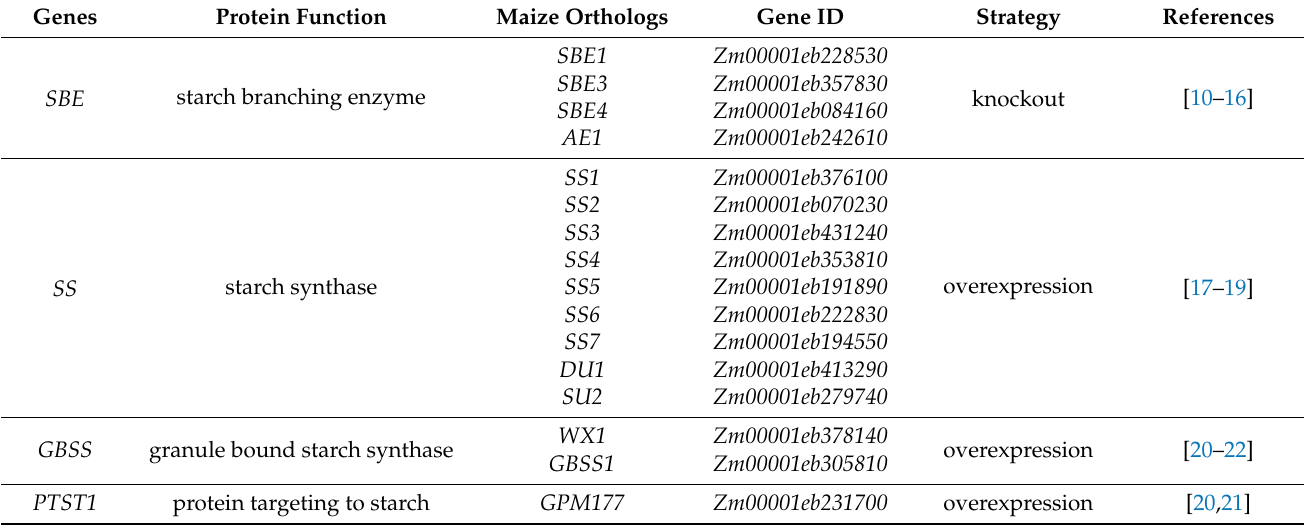
Table 1. List of potential gene resources for improving resistant starch content in maize. Genes Protein